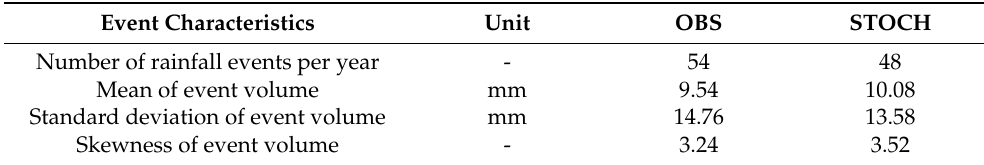
Table 4. Event characteristics of the observed rainfall series (OBS) and the synthetic rainfall series (STOCH) for the meteorological station Tianshui.